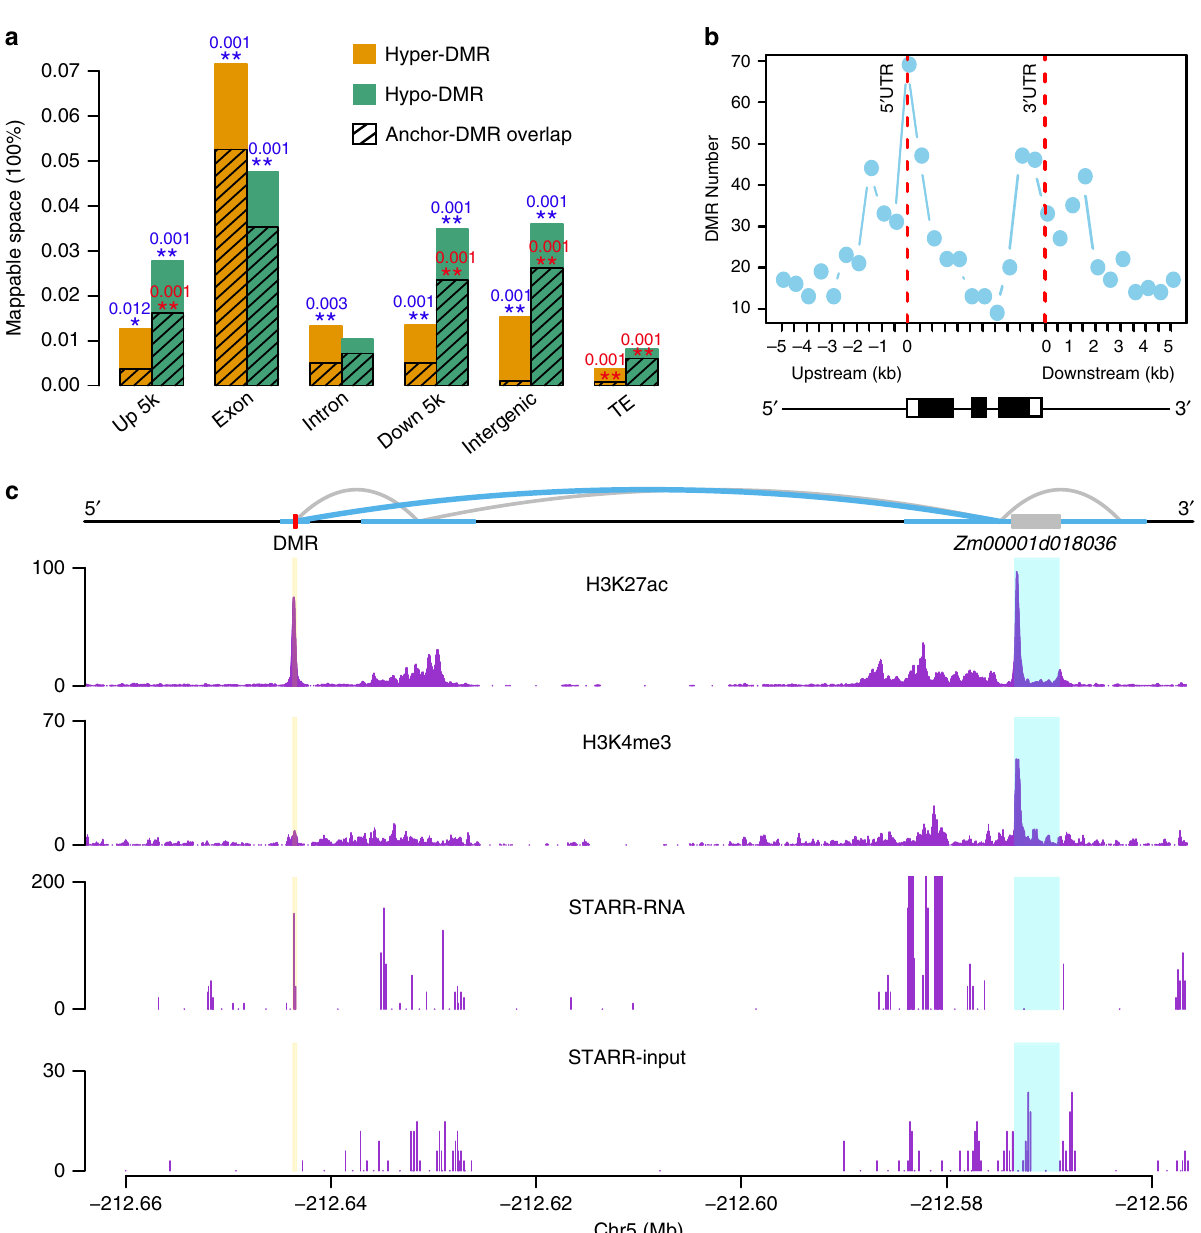
Fig. 3 Teosinte-maize CG differentially methylated regions and their associated functional features. a Breakdown of hyper-DMRs (DMR hypermethylated in maize) and hypo-DMRs (DMR hypomethylated in maize) into genomic features and their overlaps with interactive anchors using data obtained from Li et al. 33 . Blue and red stars indicated DMRs that were signi fi cantly enriched at genomic features and interaction anchors (one-sided permutation test * P -value < 0.05, ** P- value < 0.01). The numbers above the asterisks indicate the exact test P -values. b The distribution of the number of DMRs along the collapsed gene model. Below the fi gure shows a schematic gene model with three exons (black boxes). c Physical interactions (upper panel), colocalization with H3K27ac and H3K4me3 (middle panels), and STARR pro fi les (lower panels) around Zm00001d018036 gene in B73. STARR-seq data obtained from ref. 61 showed the transcriptional output (STARR-RNA) and DNA input (STARR-input) around this region. Blue curly lines indicate the interactive contacts between DMR and the candidate gene and gray curly lines indicate other interactive contacts around the region. Horizontal thick blue lines denote the interactive anchors. Red and gray boxes indicate the DMR and gene model, respectively. Source data underlying a , b are provided as a Source Data fi